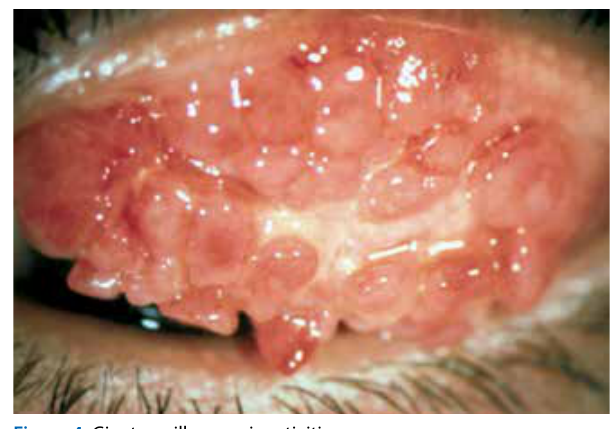
Figure 4: Giant papillary conjunctivitis